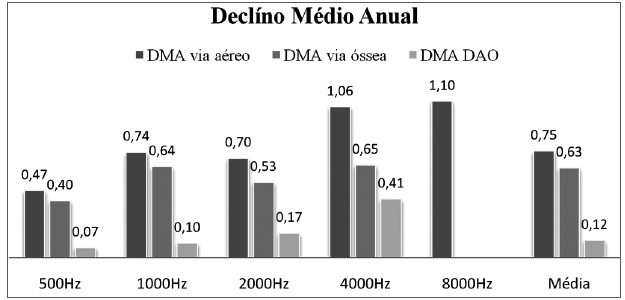
Figura 4. Declínio médio anual (DMA) dos limiares da via aérea, via óssea e diferença aéreo-óssea (DAO) por frequência. A média corresponde ao declínio dos valores médios do PTA aéreo e ósseo e DAO médio.